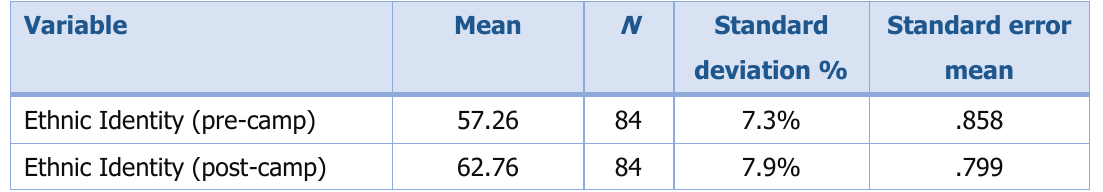
Table 2. Ethnic Identity Growth Descriptive Statistics Variable